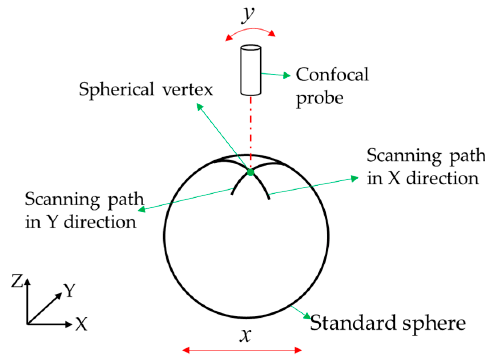
Figure 11. Method of locating the center position of a calibration sphere.